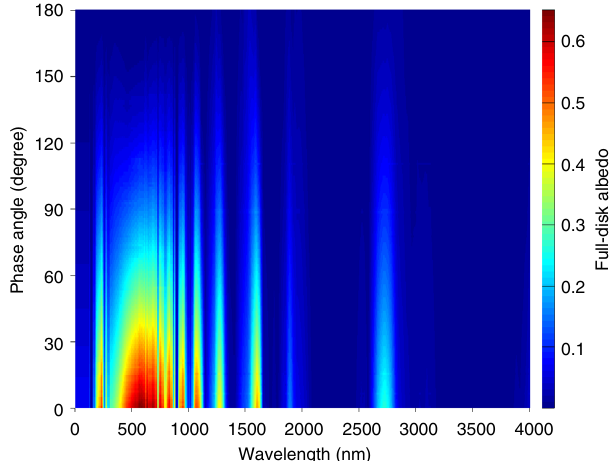
Fig. 2 Jupiter ’ s albedo in the two-dimensional domain of phase angle and wavelength. The full-disk albedo with varying phase angle (0° – 180°) is displayed in the wavelength range of 0 – 4000 nm, in which more than 99% of the total solar power is concentrated